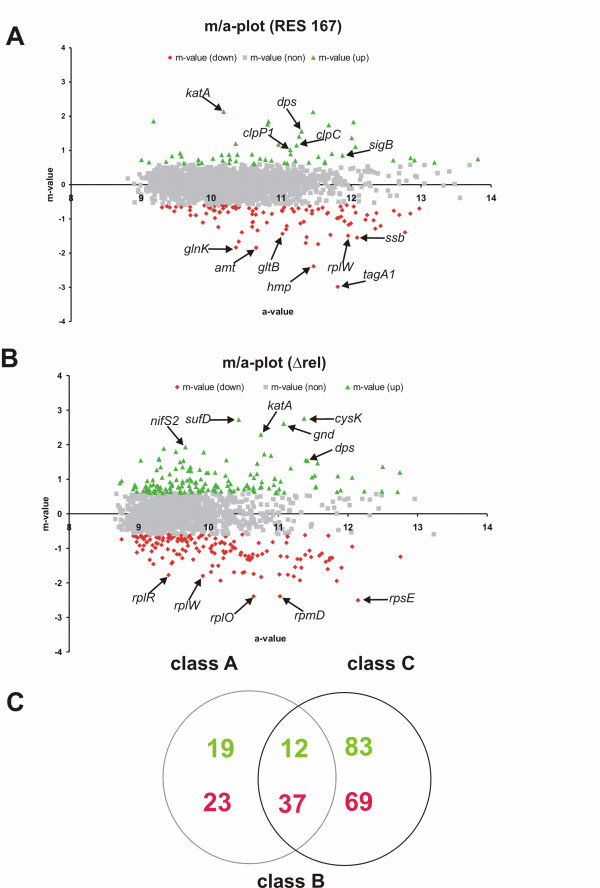
DNA microarray hybridizations of the C. glutamicum RES167 and the C. glutamicum RES167Δrel mutant strain. (A) and (B) Scatter plots (m/a plots) of the experiments. Shown are all genes whose transcription has been significantly up- (green) or downregulated (red) after induction of the stringent response by DL-serine hydroxamate. Genes which showed the most prominent changes in expression are labelled. (C) Venn diagram of the differentially expressed genes in the C. glutamicum RES 167 and Δrel mutant after treatment with SHX is shown. The numbers of genes which were placed in each of the three classes A, B and C is given. Green numbers represent upregulated genes, red ones represent downregulated genes.